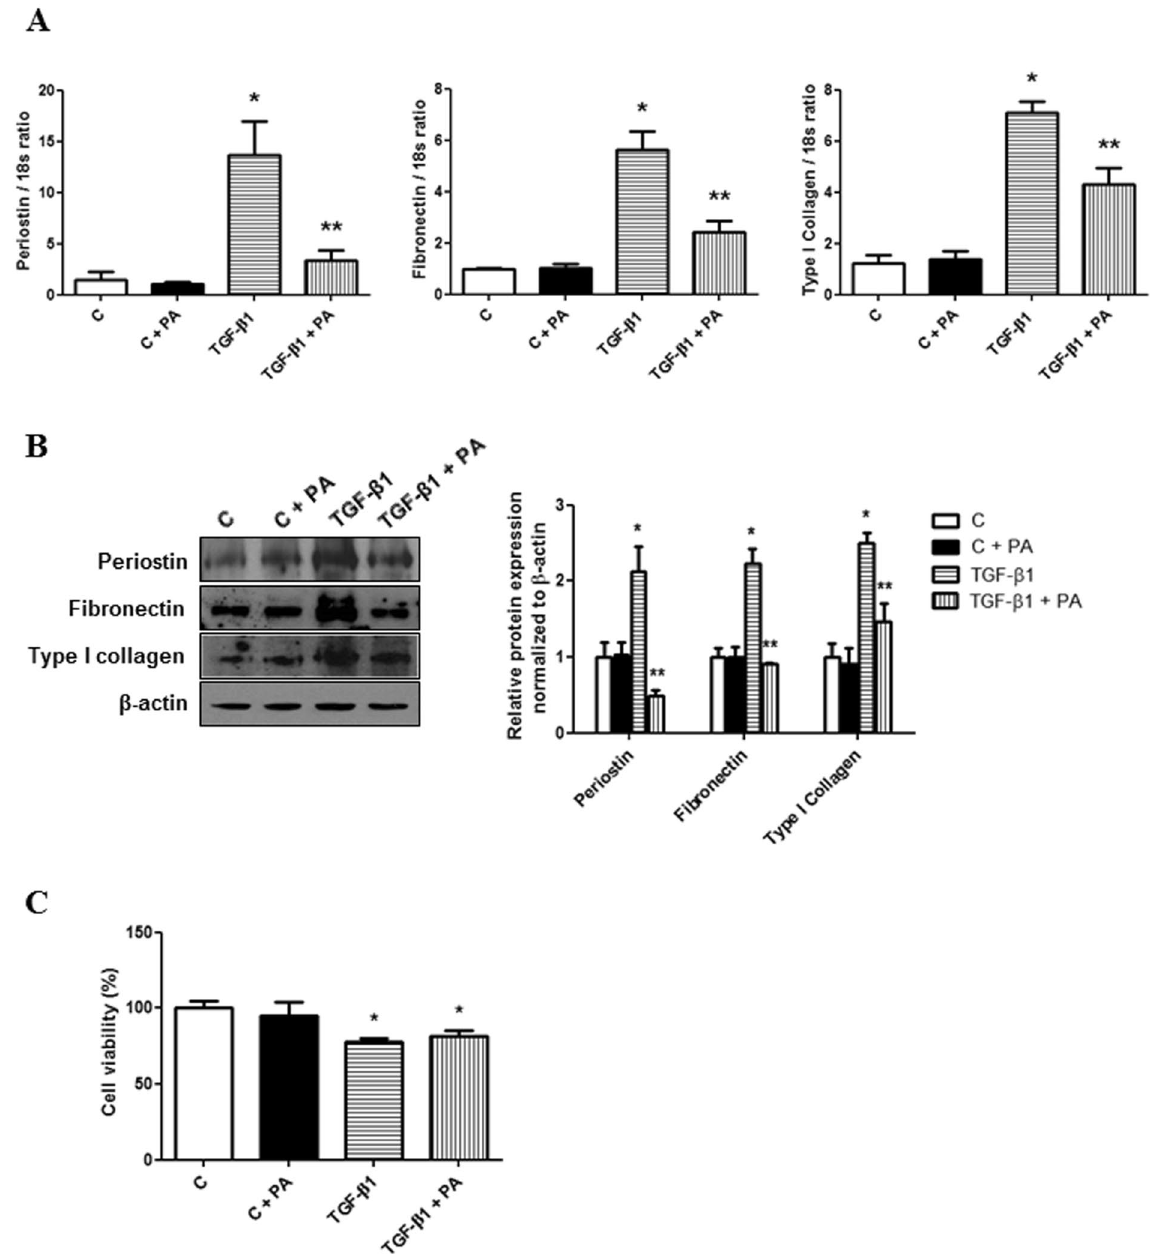
Figure 4. Changes in periostin, fibronectin, and type I collagen expression following periostin-binding DNA aptamer (PA) administration in inner medullary collecting duct (IMCD) cells treated with or without transforming growth factor- β 1 (TGF- β 1). ( A ) Periostin, fibronectin, and type I collagen mRNA levels (n = 6). Treatment with PA (100 pmol/ml) significantly ameliorated TGF- β 1-induced (10 ng/ml) periostin, fibronectin, and type I collagen mRNA expression. ( B ) Representative western blotting analysis of periostin, fibronectin, and type I collagen protein levels (a representative of four blots). The increases in the protein levels of periostin, fibronectin, and type I collagen in TGF- β 1-stimulated IMCD cells were significantly attenuated by the PA. Uncropped scans are presented in Supplementary Figure 4. ( C ) Cell viability in IMCD cells with or without treatment of PA and TGF- β 1. Cell viability was not affected by PA treatment. However, cell viability was significantly decreased in TGF- β 1-stimulated IMCD cells. C, control; PA, periostin-binding DNA aptamer. * P < 0.05 vs. C; ** P < 0.05 vs. TGF- β